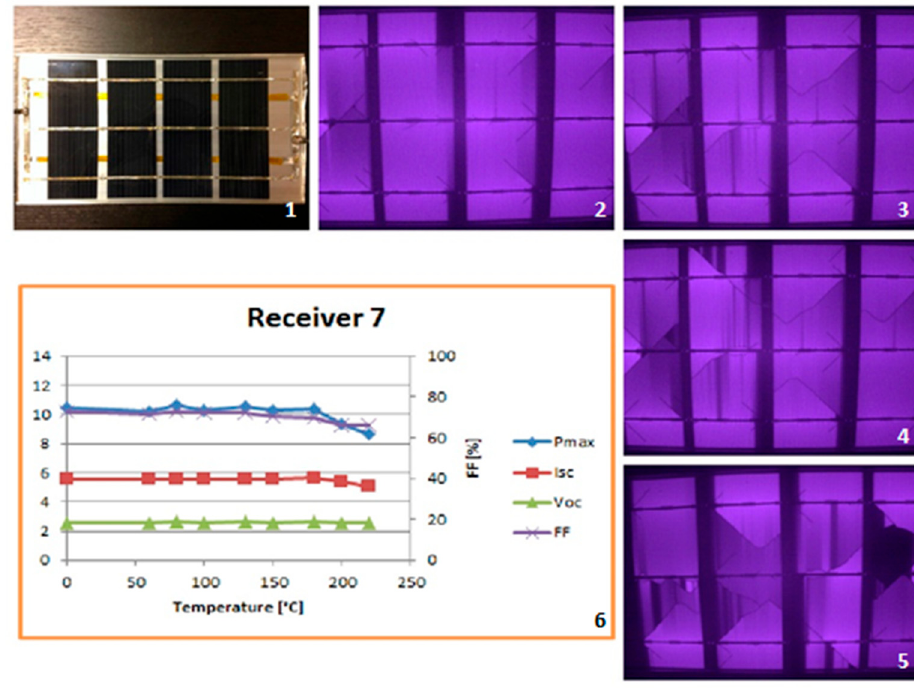
Figure 15. ( 1 ) Receiver 7; ( 2 ) Baseline Round; ( 3 ) Round 5 (150 °C); ( 4 ) Round 6 (180 °C); ( 5 ) Round 8 (220 °C); ( 6 ) Parameters of the IV curve at different temperatures (Isc, Voc and Pmax shown in the left Y axis and FF in the right Y axis).